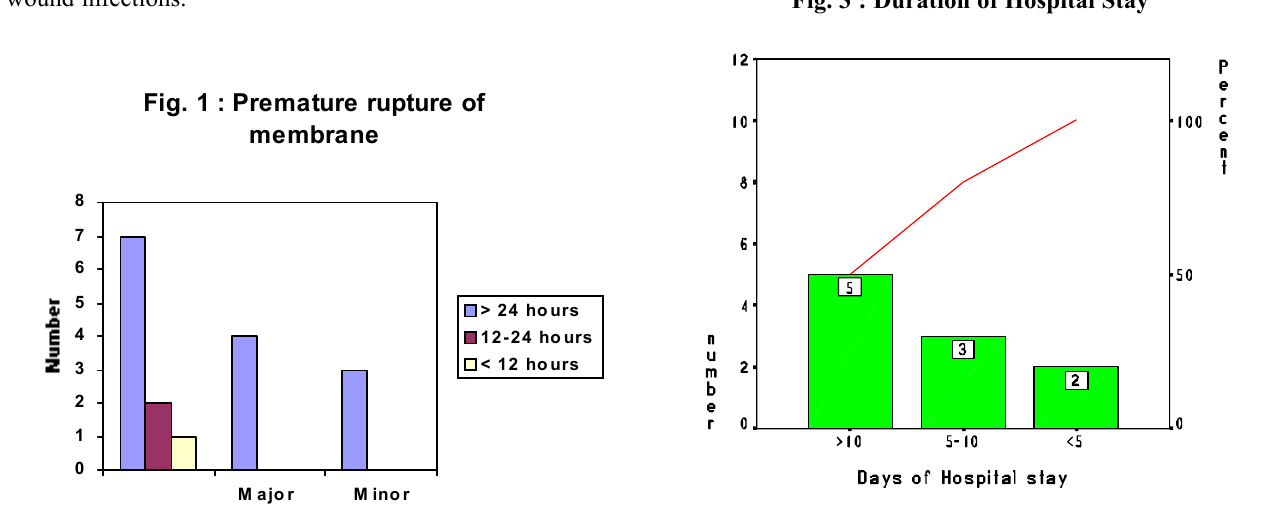
Fig. 3 : Duration of Hospital